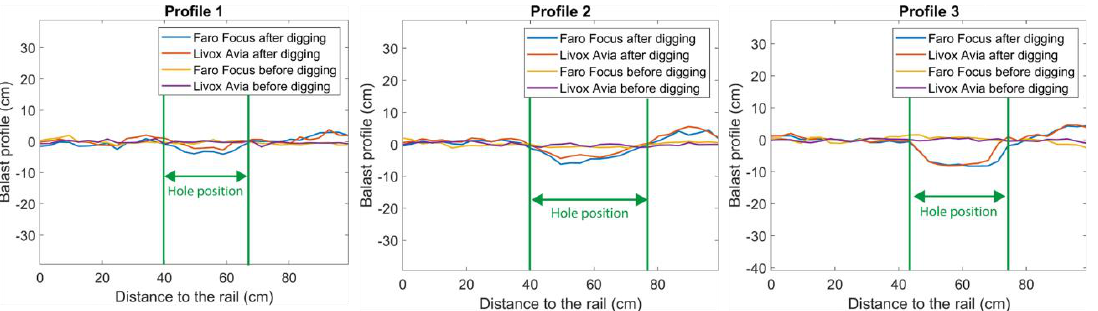
Figure 8. Ballast profiles comparing the results of the LiVOX Avia and Faro Focus 3D, before and after digging the holes.